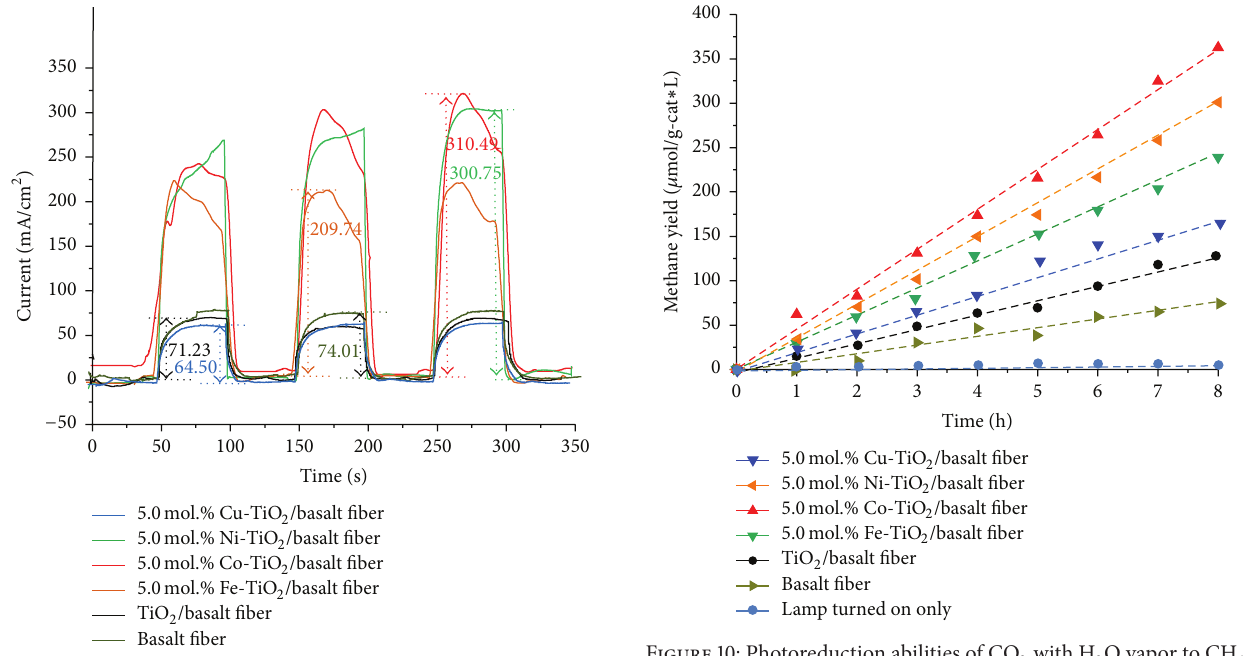
Figure 9: Photocurrent responses of the pure basalt fiber and 5.0 mol.% M-TiO 2 /basalt fiber films when the light source was switched on and off.